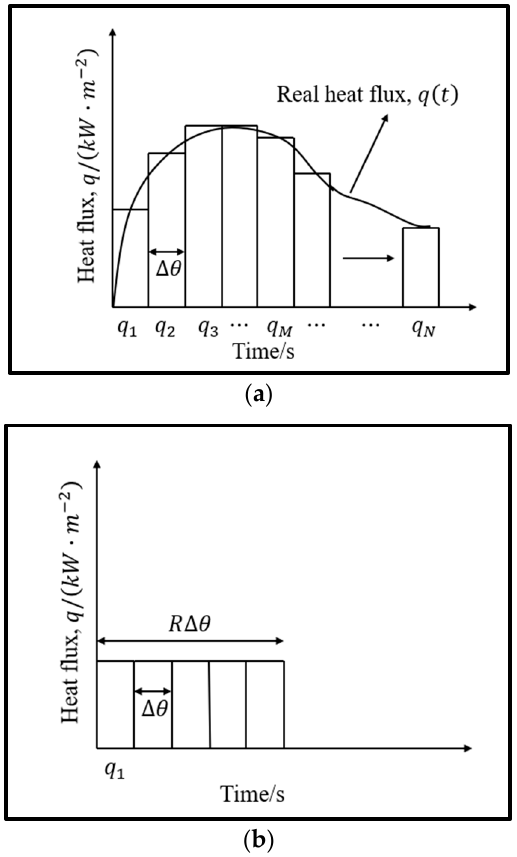
Figure 3. Heat flux solved by discrete solution. ( a ) The actual heat flux q ( t ) is dispersed into a series of values. ( b ) The heat flux is assumed to be constant in the 𝑅∆𝜃 time.